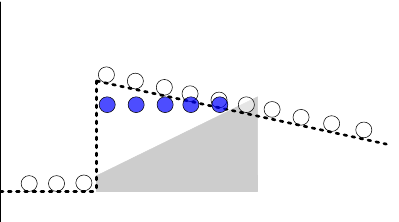
Figure 5. Example of filtering ground surface of abrupt changes (the blue points are not retrieved to